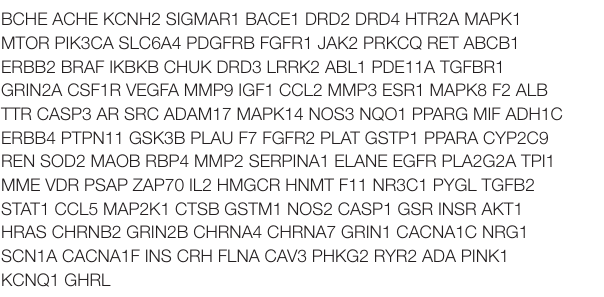
TABLE 3 | Intersection genes between AD and DNP related genes.